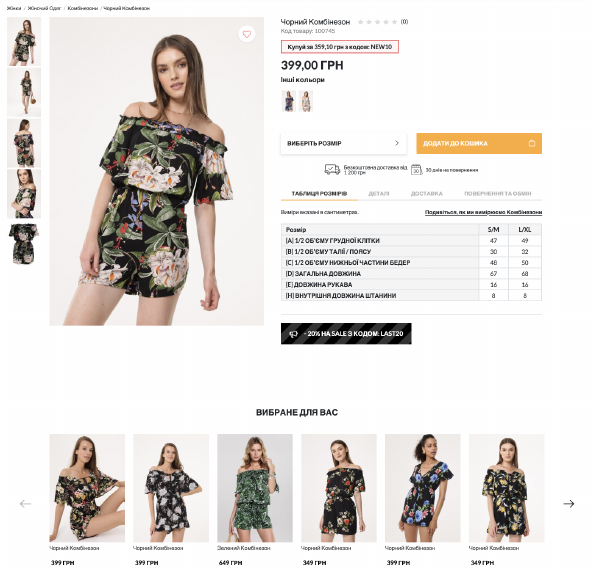
Figure 4. Recommendation box—cold start in a session based on previous user behavioural history.